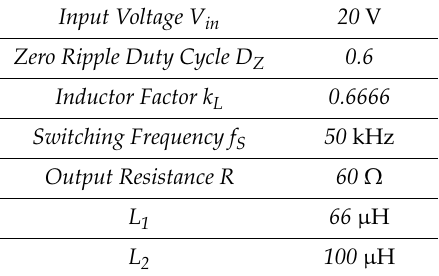
Table 1. Experimental setup parameters.